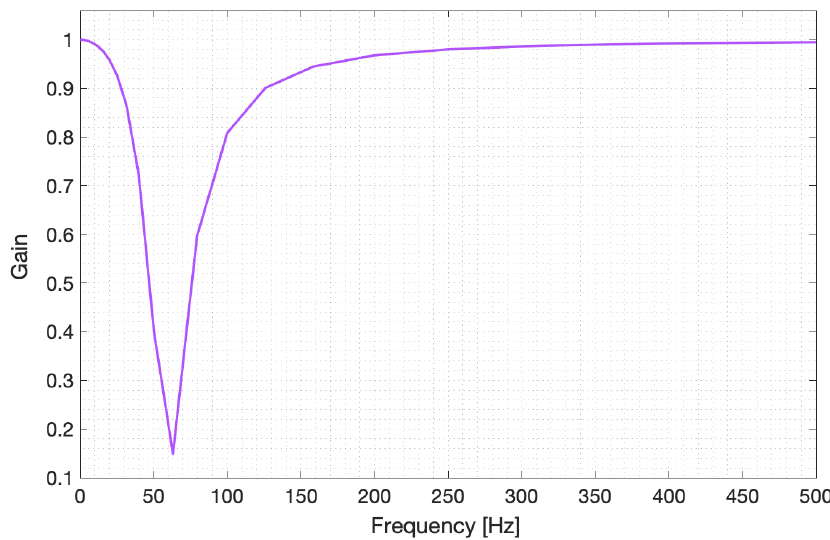
Figure 7. Magnitude response for the notch filter. The plot shows the filter’s gain for different sinusoidal inputs frequencies. The filter is configured to reject the power line frequency of f n = 60 Hz.